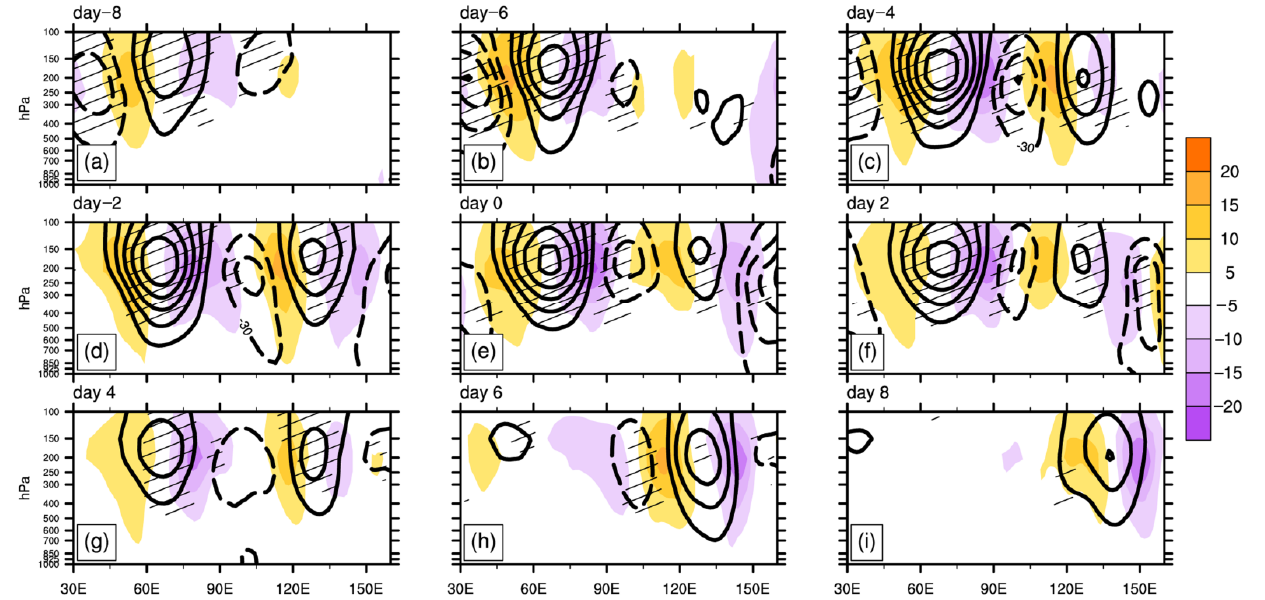
Figure 5. Longitude-pressure cross-section of geopotential height anomalies (contours are from −120 gpm to 120 gpm with the interval of 30 gpm) and meridional wind anomalies (shadings; units: m s −1 ) along 40° N during the SRP+ events ( a – i : from day −8 to day 8). The slash shadings indicate that the height anomalies are statistically significant at the 0.05 confidence level. The numbers at the top-left corner above each panel represent the days leading (negative) and lagging (positive) the peak date of the SRP+ events.